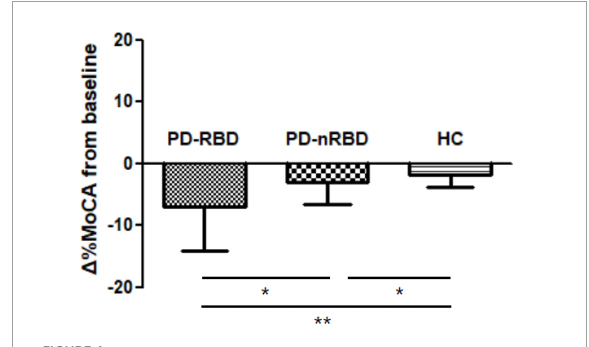
FIGURE4 Cognitive decline by (cid:49) %MoCA from baseline to 36 month in PD patients with and without RBD (PD-RBD and PD-nRBD) and healthy controls (HCs). P value was assessed using independent t -test between each group, * P < 0.05, ** P <